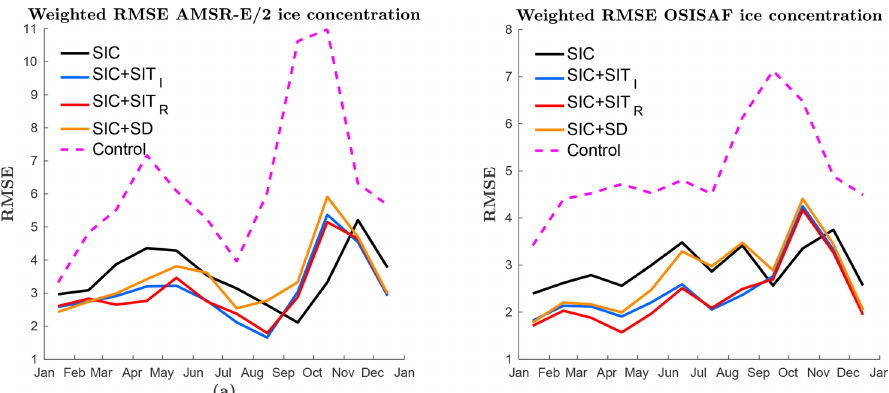
Figure 8. RMSE of monthly averaged (over 3 years) ensemble mean of 7-day forecast SIC validated against (a) AMSR-E/2 SIC observations and (b) OSISAF SIC